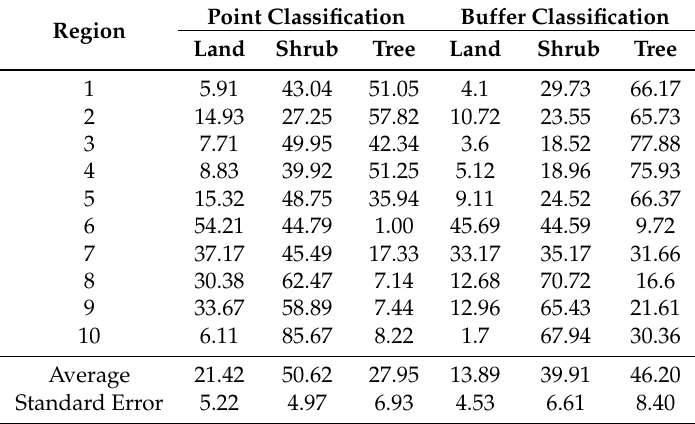
Table 1. Distribution of labeled examples by class and tile, for both point and buffer labeling systems (expressed in